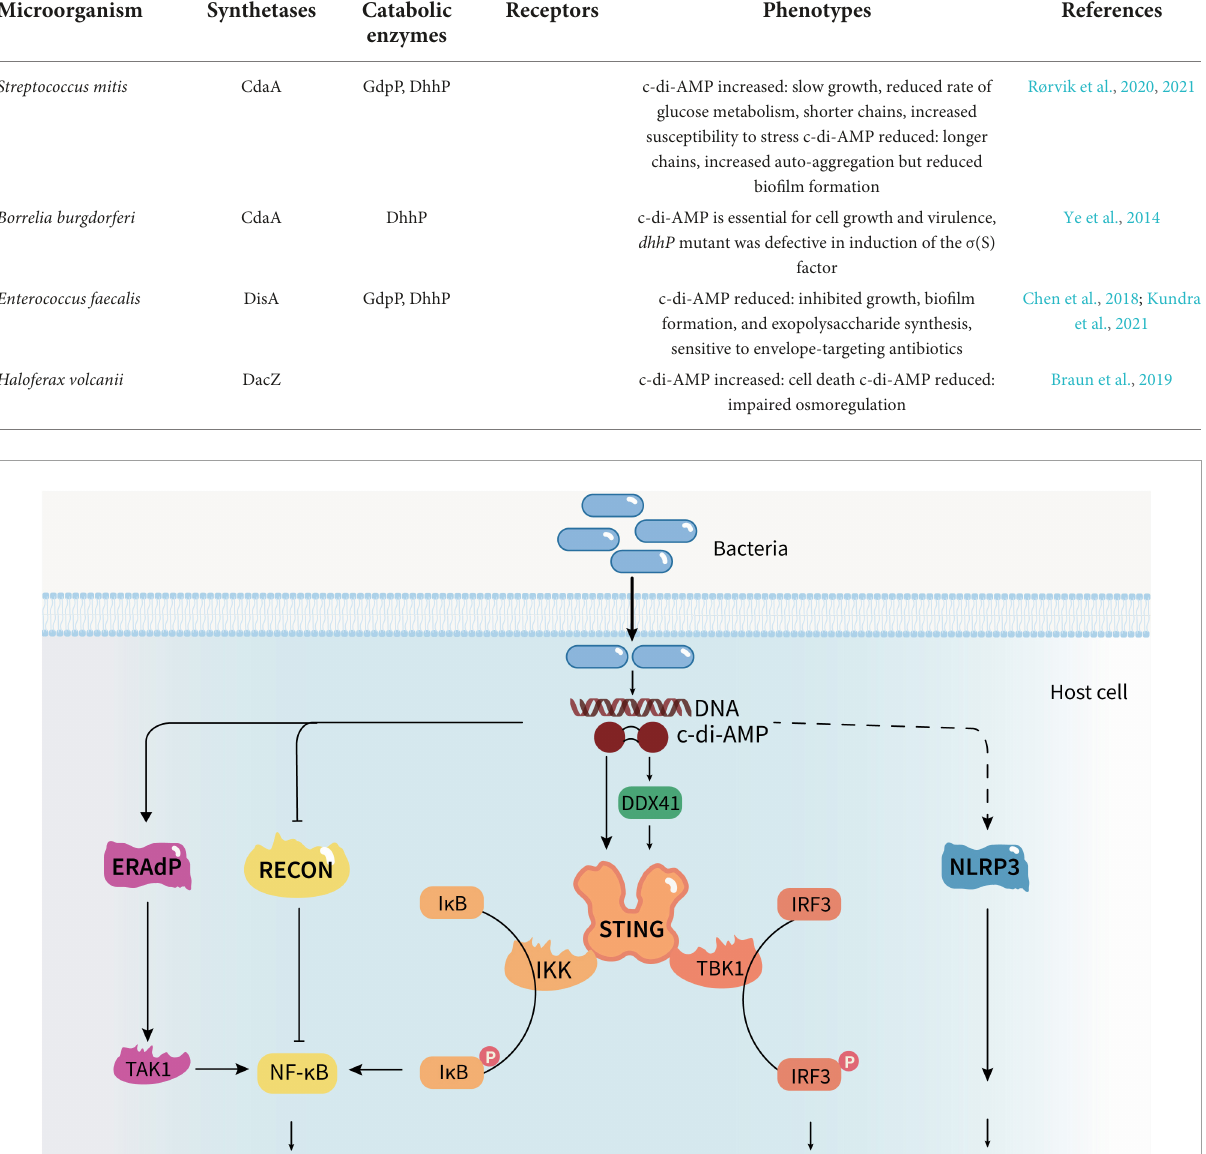
FIGURE2 Cyclic di-adenosine monophosphate regulates the host’s innate immune response. c-di-AMP produced by pathogens can be recognized by host cells and activate host innate immune responses. It can induce a type I IFN response in a STING-dependent manner, trigger the nuclear factor kappa B (NF- κ B) pathway by activating ERAdP or inhibiting RECON, induce NLRP3-dependent inflammasome response, and activate host cell autophagy, promoting the production and secretion of cytokines.